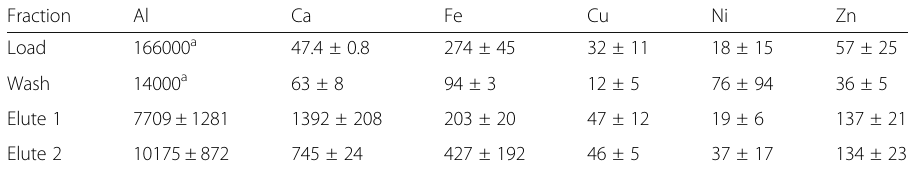
Table 2 Trace metal content in ppb ( μ g/L) determined by ICP-MS ( n = 2) Fraction Al Ca Fe